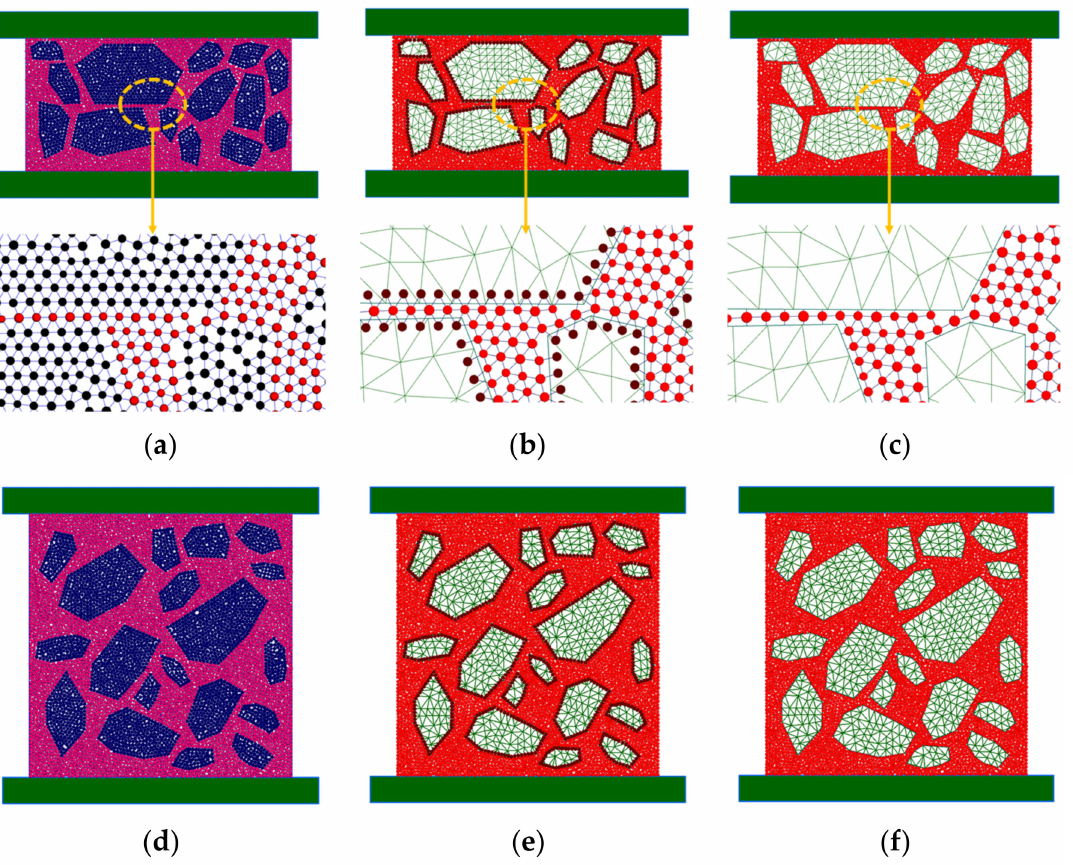
Figure 6. Particle models adopted for uniaxial testing: ( a ) Tensile test (DEM); ( b ) Tensile test (H-FEM-